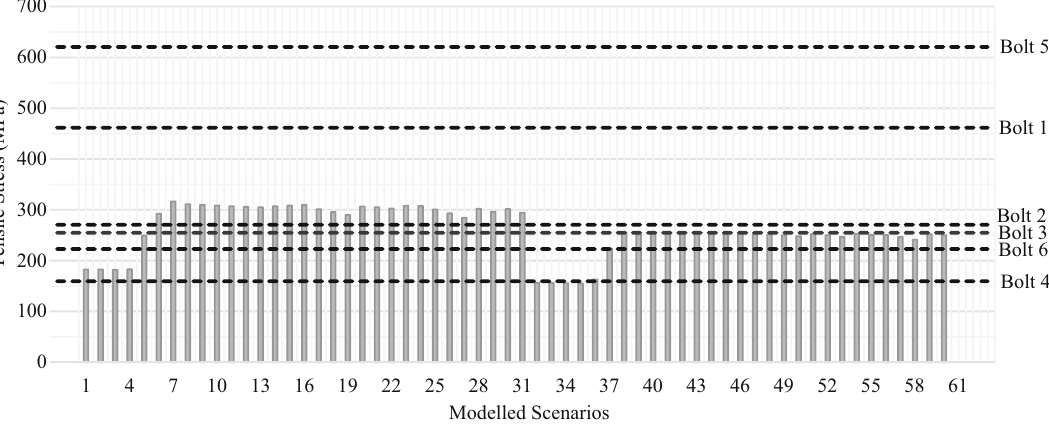
Fig. 4 Maximum bolt tensile stress from previous work by Hebblewhite and Lu (2004) superimposed against maximum bolt tensile stress data for all 60 modelled iterations. Modelled results are well represented by bolts 2, 3, 4 and